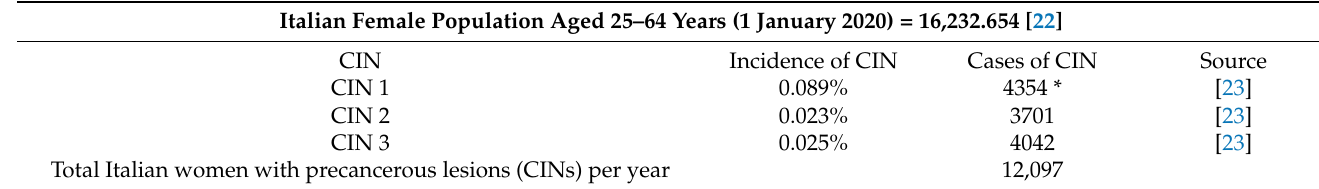
Table 1. HPV-related precancerous lesion population.